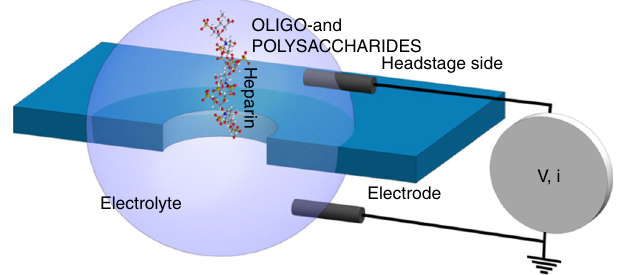
Fig. 1 Schematic of the nanopore setup. Voltage-driven passage of a molecule into, across, or through an electrolyte- fi lled nanopore can be used for analyte detection and